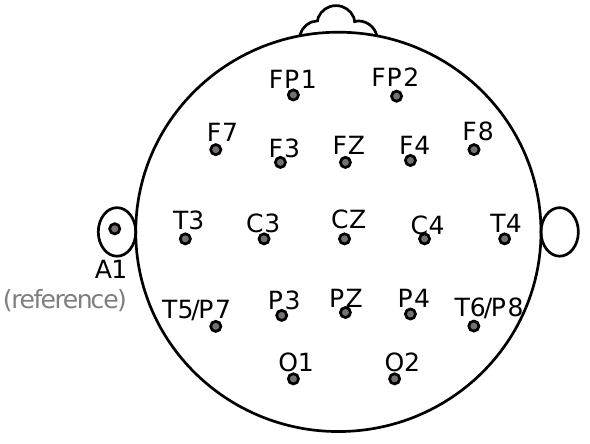
Figure 1. EEG electrode